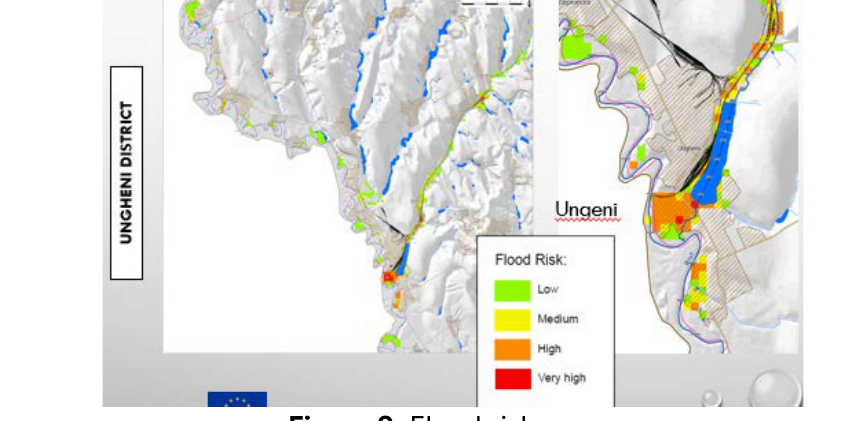
Figure 9. Flood risk maps.